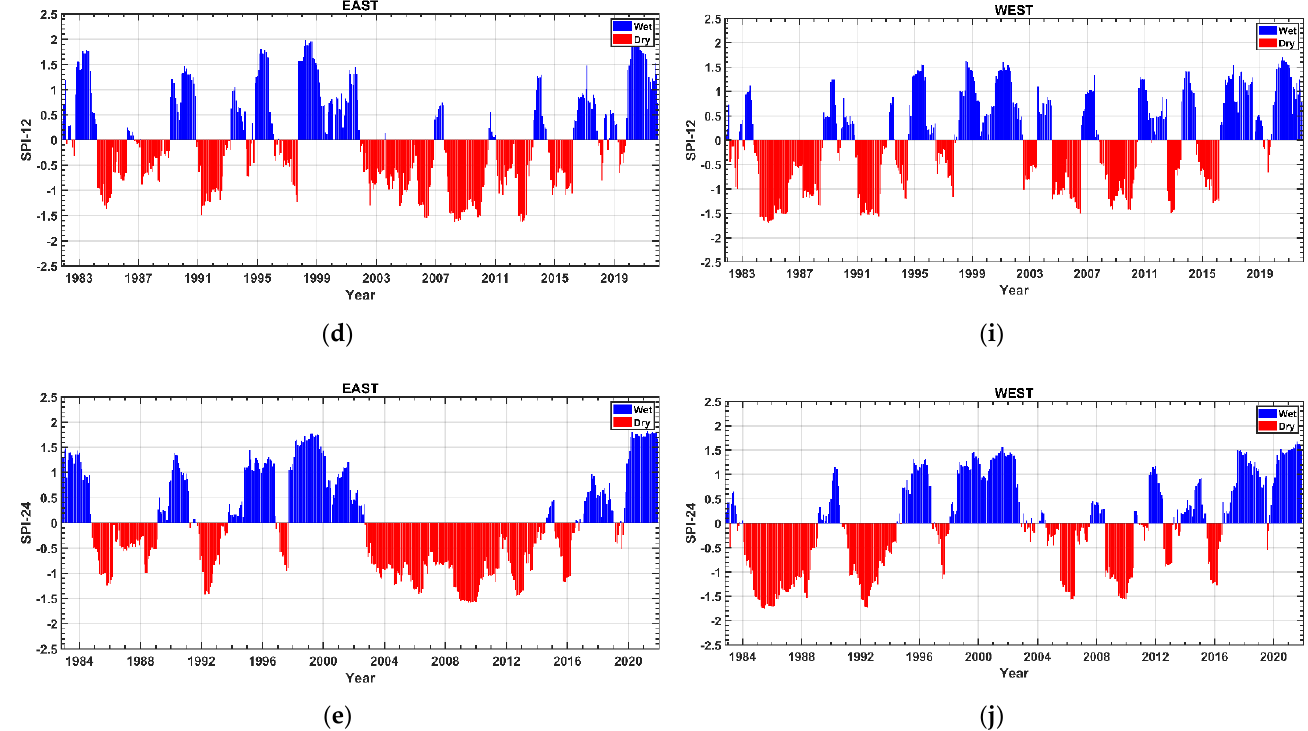
Figure 10. Spatiotemporal variation of the SPI (3, 6, 9, 12, and 24 months) for the EAST (left panels ( a – e )) and WEST (right panels ( f – j )) subregions computed with CHIRPS during 1981–2021 .